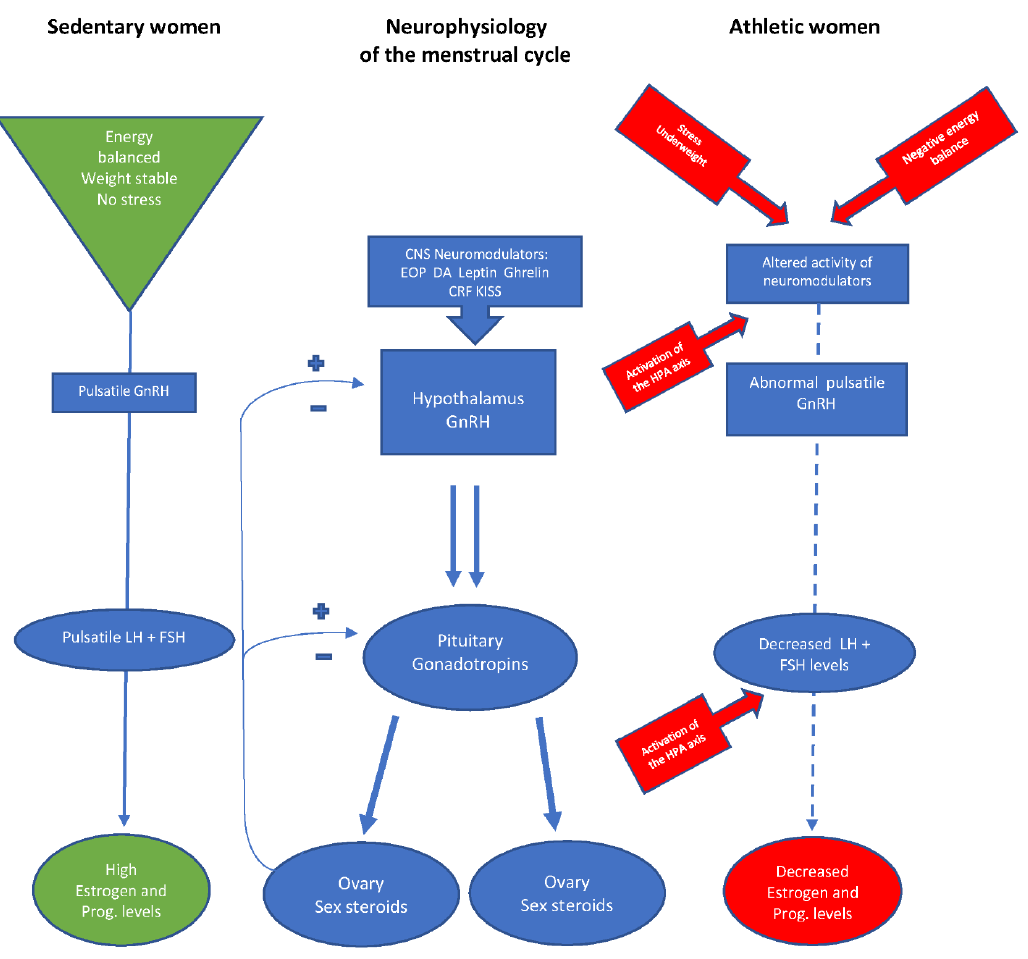
Figure 1. Schematic presentation of the neurophysiology of the hypothalamic-pituitary-ovarian axis and the effects of sports and exercise on the neuroendocrine control of reproduction.